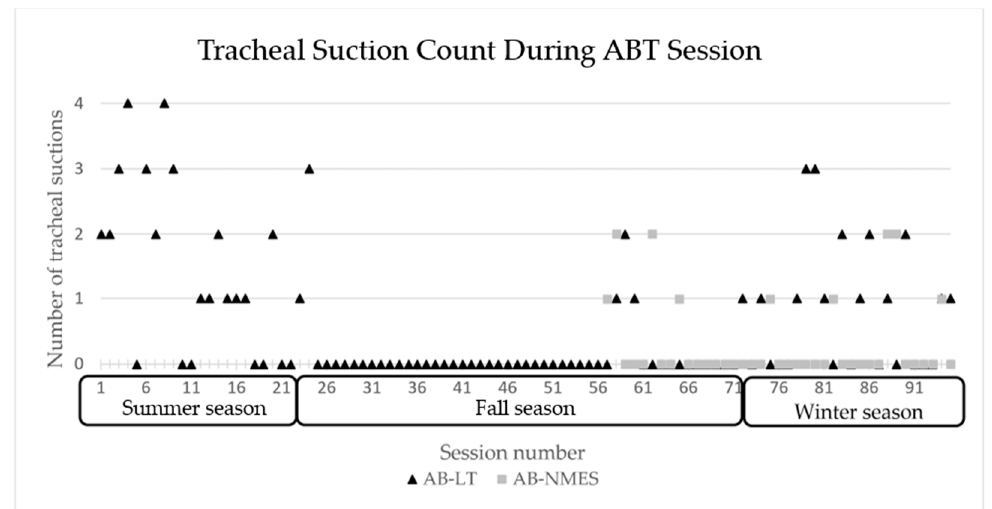
Figure 5. Number of tracheal suctions required during each ABT session 1–94 across seasons. AB-NMES initiated at session number 56. ABT= activity-based therapy, AB-LT = activity-based locomotor training. AB-NMES = activity-based neuromuscular electrical stimulation.